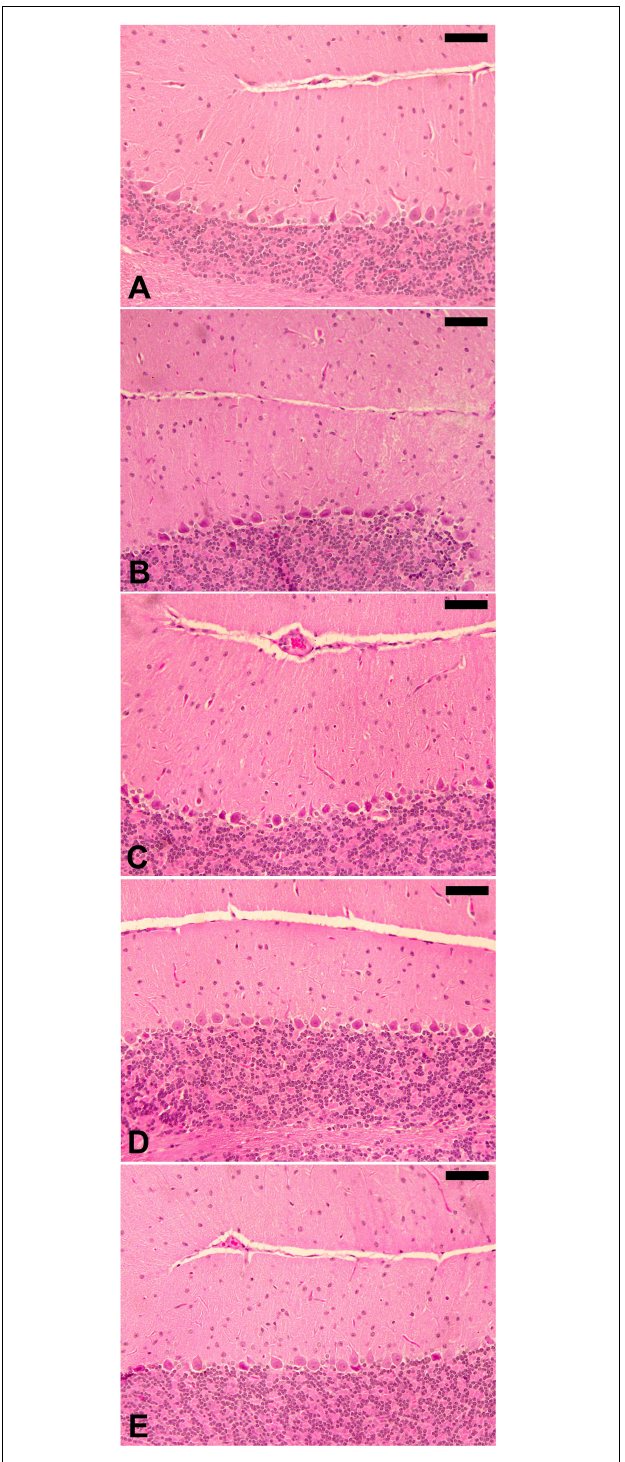
FIGURE 4 | E. camaldulensis improves the brain histopathology after infection with T. evansi . Normal structure of control cerebellum (A) and ELE-treated (B) mice. (C) Infected cerebellum of mice with injured Purkinje cells and dilated sinusoids between the molecular layers. (D) ELE-treated infected cerebellum with improved structure. (E) Drug-treated cerebellum with improved structure. Scale bar = 25 µ